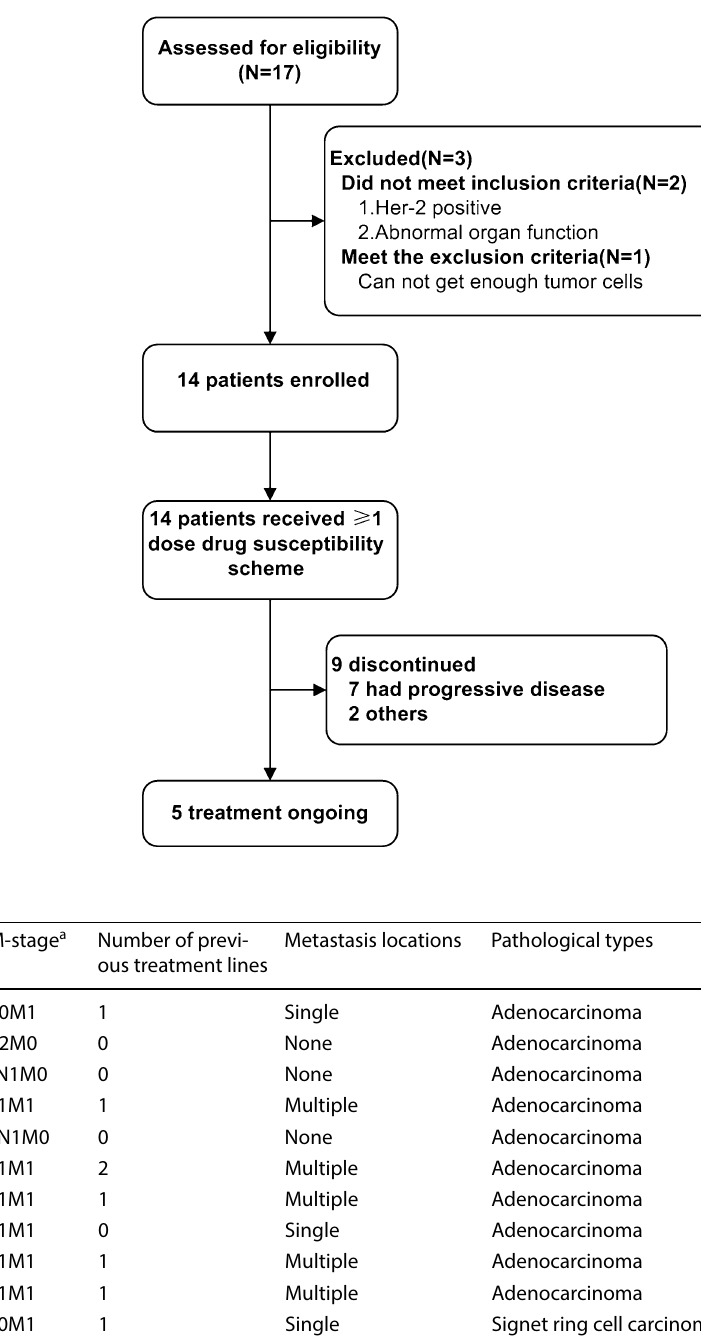
Fig. 1 Flow chart of the study